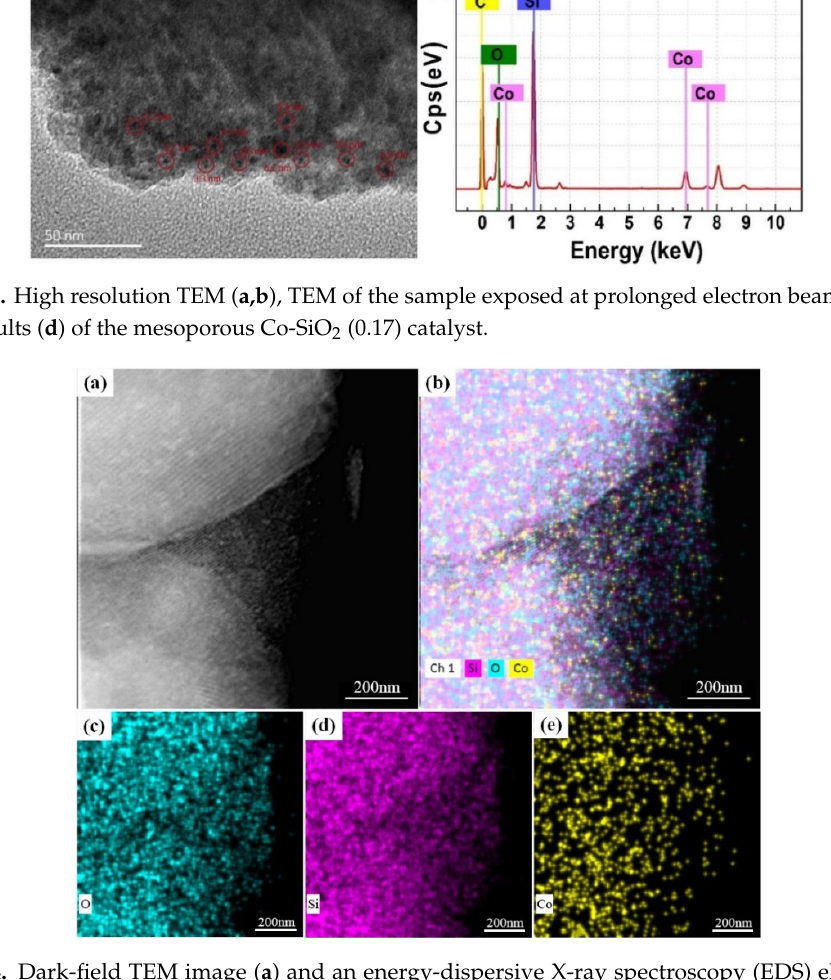
Figure 4. Dark-field TEM image ( a ) and an energy-dispersive X-ray spectroscopy (EDS) elemental mapping ( b – e ) of the Co–SiO 2 (0.17) catalyst.